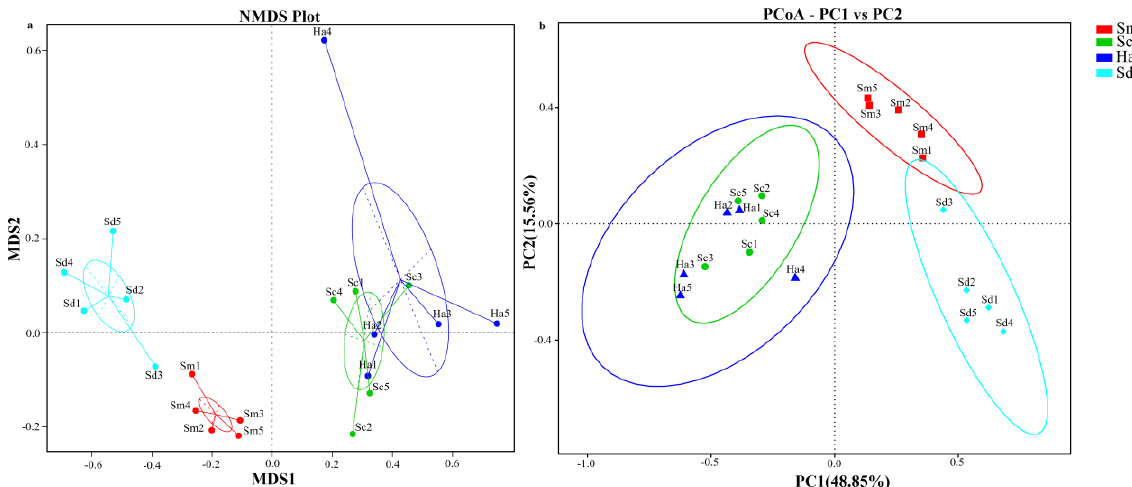
Animals 2022 , 12 , x 9 of 15 1 Sm (S. monotuberculatus), Sc (S. chloronotus), Ha (H. atra). 3.3. Relationships of Eukaryotic Communities among the Gut and Sediment Samples NMDS and PCoA analysis were performed to assess the similarity of the eukaryotic composition among different samples (Figure 6). The analyses indicated that the samples from sediments and guts of the three species of sea cucumbers were clustered separately into three groups: all the sediment samples, gut content samples of S. monotuberculatus , and all the gut content samples from S. chloronotus and H. atra . UPGMA clustering tree at